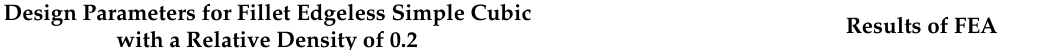
Table 3. FEA results for the multipipe edgeless simple cubic unit cells. Design Parameters for Fillet Edgeless Simple Cubic with a Relative Density of